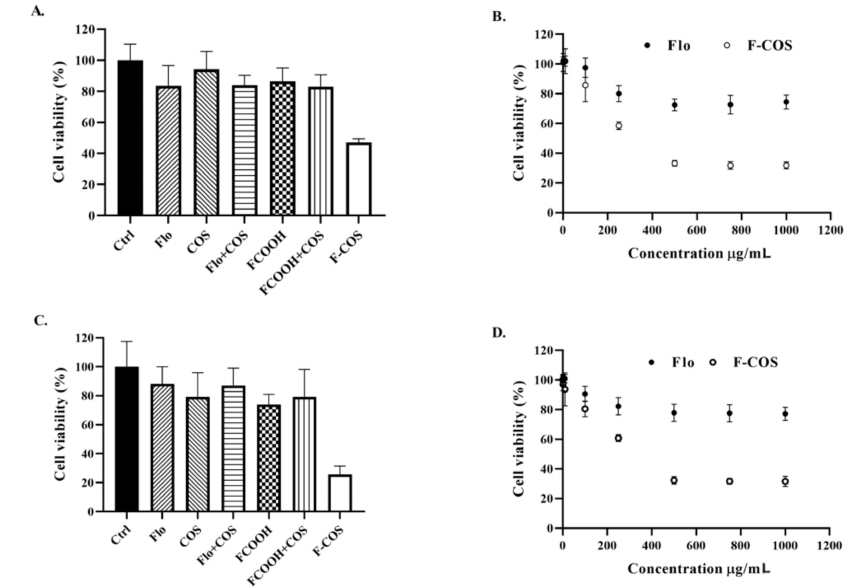
Figure 4. F-COS eradicated Streptococcus hyovaginalis biofilms. The anti-biofilm activity of F-COS, florfenicol (Flo), COS, a 1:1 mixture of florfenicol and COS (Flo + COS), Flo-COOH (FCOOH), a 1:1 mixture of FCOOH and COS (FCOOH + COS) were tested against mature biofilm of Streptococcus hyovaginalis ( A ) or planktonic cellsculturedinbiofilmformationcondition( C ),ataconcentrationof250 µ g / mL.Theconcentration-dependent of anti-biofilm activity of F-COS against mature biofilms ( B ) or inhibiting biofilm formation ( D ) were shown. Data are represented as means ± SD (n = 6) of cell viability compared to the untreated